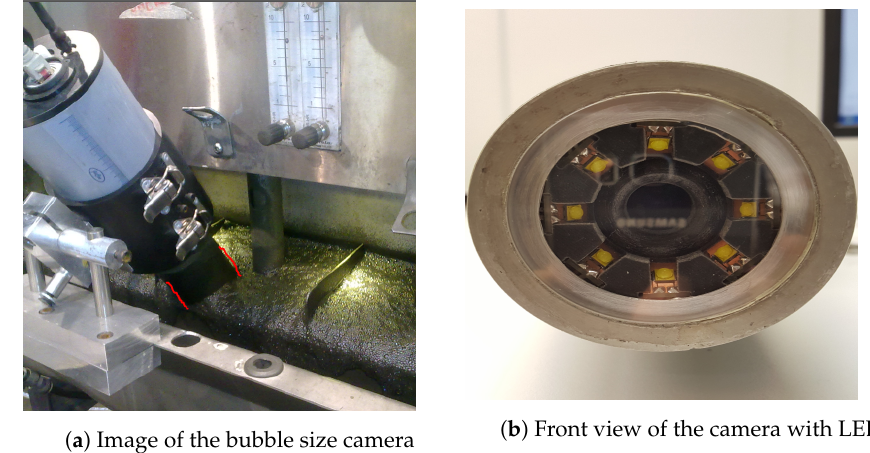
Figure 1. Setup of the bubble size measurements where, ( a ) shows the image of the bubble size camera and ( b ) shows the front view of the camera containing